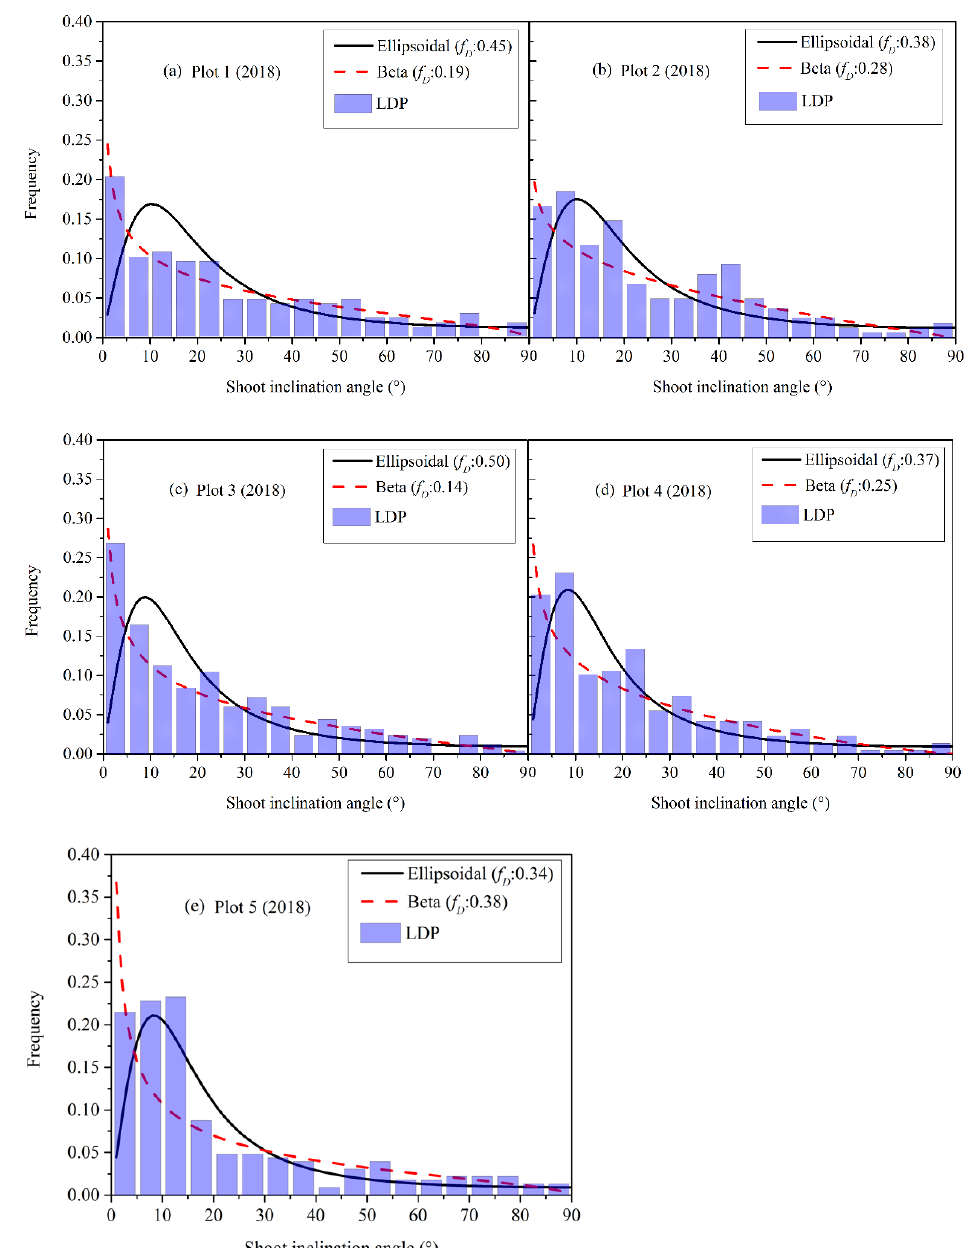
Figure 4. A comparison of the beta and ellipsoidal distribution functions used to fit the whole-canopy